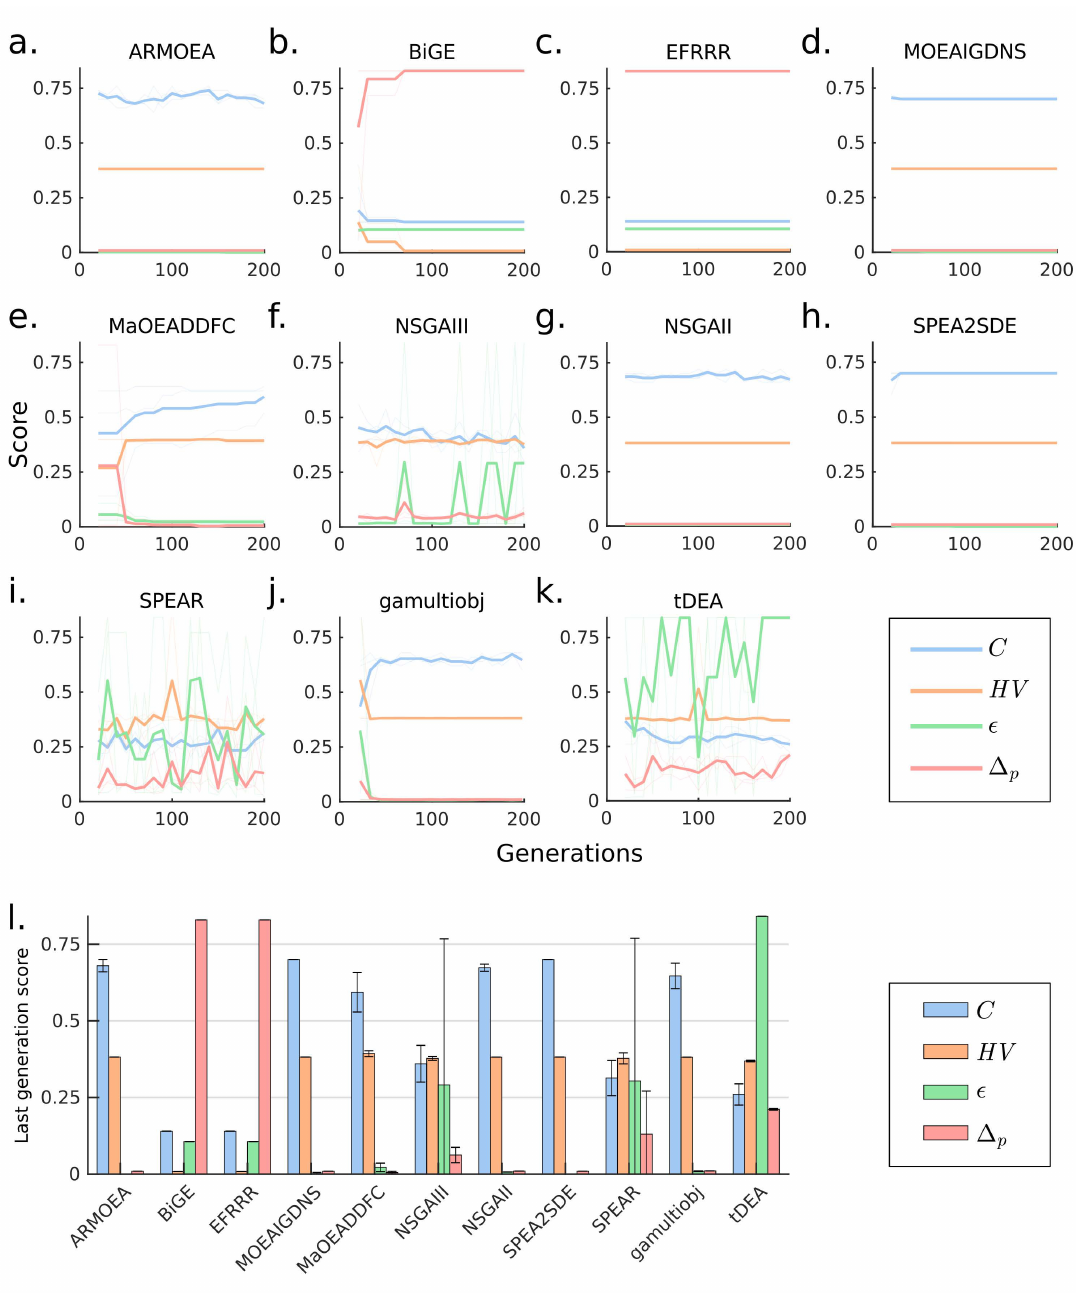
Figure 4. Comparison of MOEAs for a 10-objectives design problem with larger population sizes ( a – k ) Generation-dependent performance metrics for various MOEAs. ( l ) Performance metrics for various MOEAs at the last